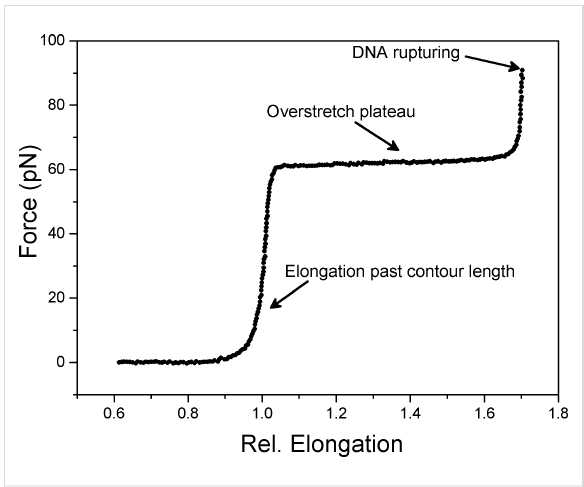
Figure 3: Characteristic force–extension curve. The biotin bead inter- acting with the protein moiety by molecular recognition is moved away from the DNA-labelled bead in the trap at a constant velocity of 100 nm/s until rupturing occurs. Lower pulling speeds, e.g., 10 nm/s and 50 nm/s were tested and resulted in similar force versus exten- sion plots.